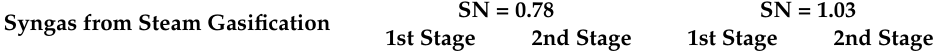
Table 6. Experimental and modeled results from sub- and over-stoichiometric methanation strategies. Syngas from Steam Gasification